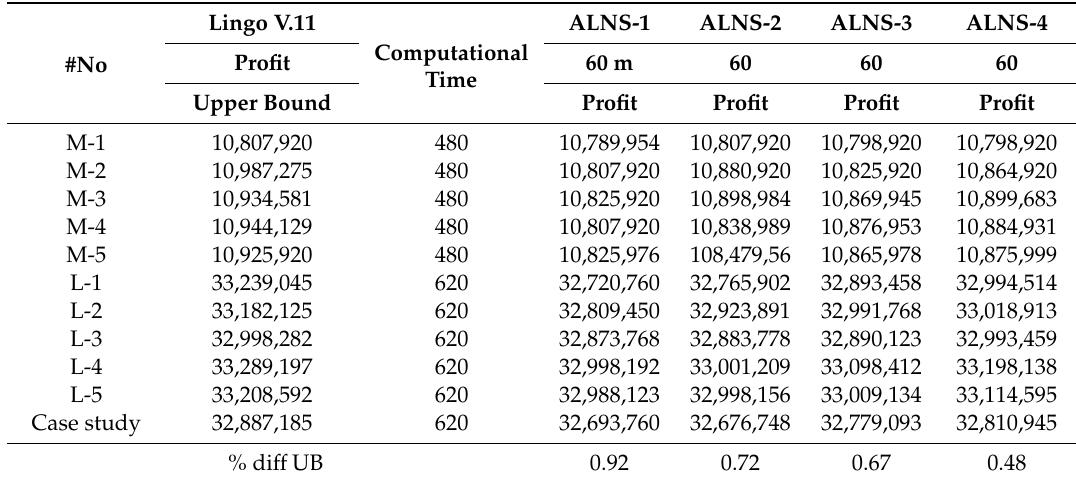
Table 10. Computational consequence of the medium and large data set and the case